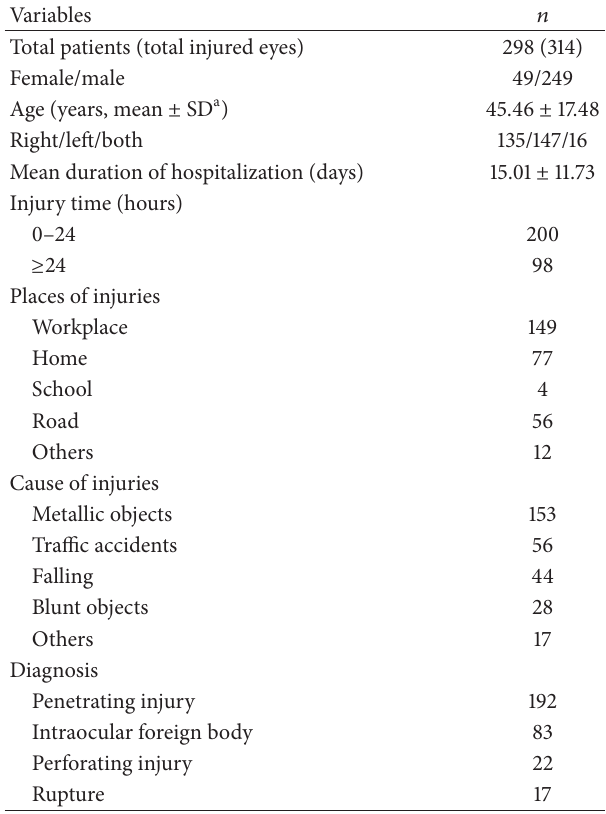
Table 2: Characteristics of patients with open globe